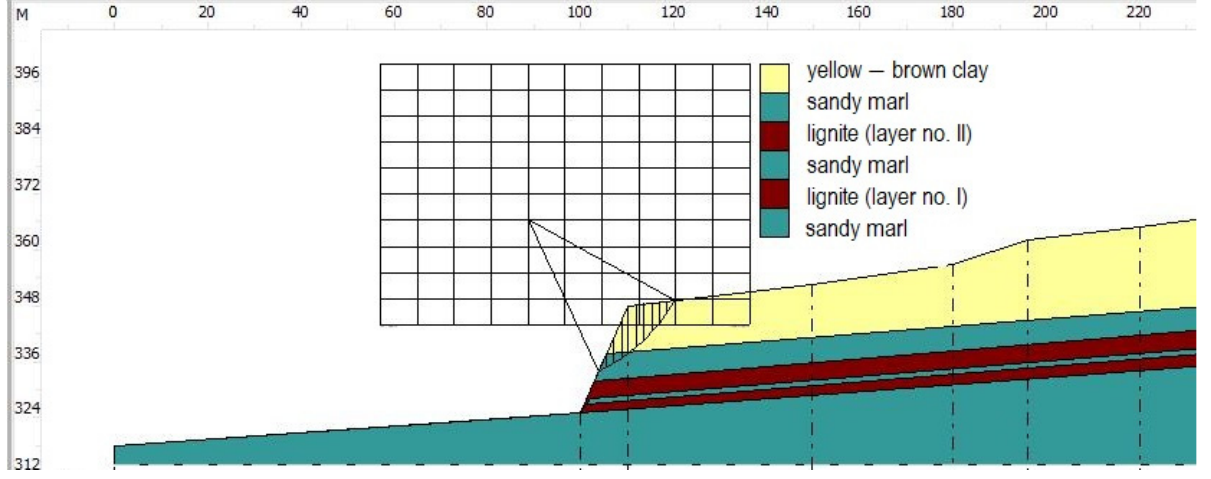
Figure 7. Section L1, F s1 = 1.01 (Dec. 2021).